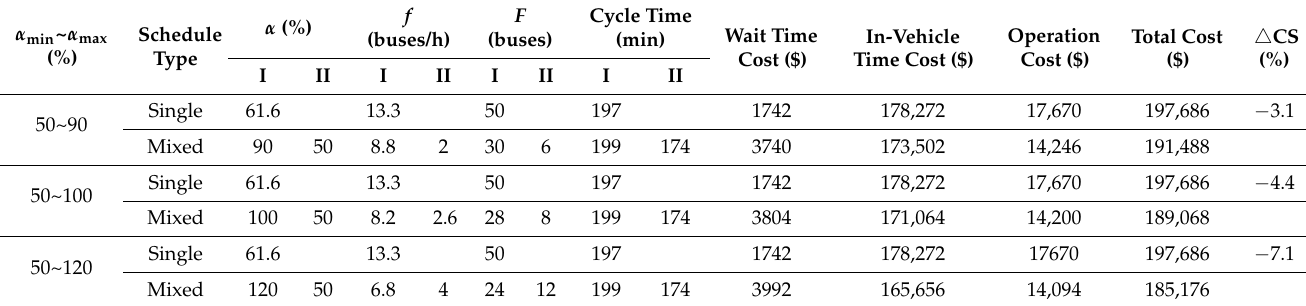
Table 2. Frequencies, fleet size and costs of different load factor